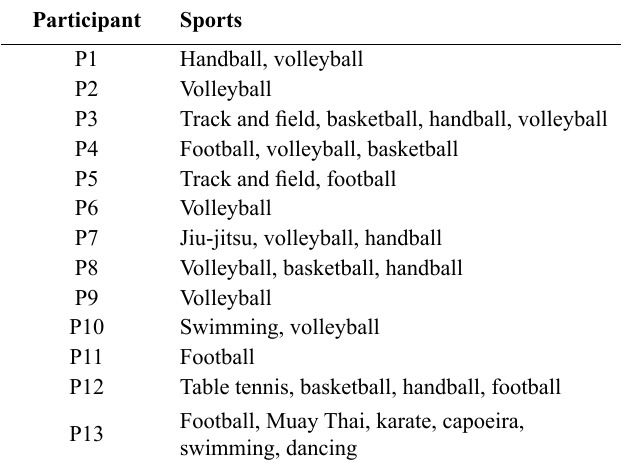
Table 3 – Sports practices during childhood, except